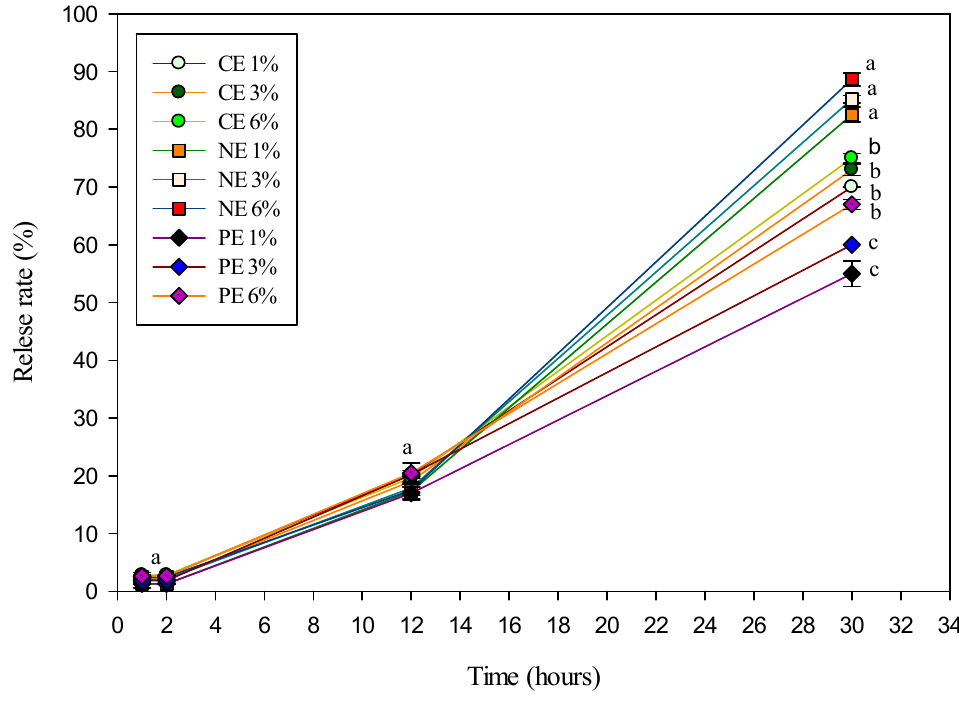
Figure 5. Release rate of LDPE film treated with cold plasma containing CE-, NE-, and PE-stabilized MFEO in 95% alcohol. Values with different superscripts are significantly different at p < 0.05. The error bars represent the standard deviation (n = 3).